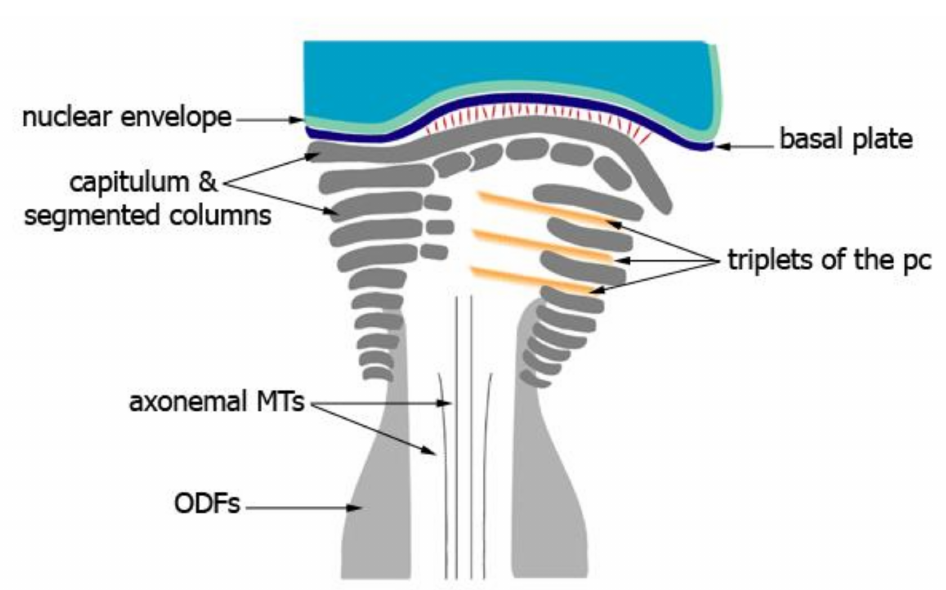
Figure 2. Schematic drawing of the connecting piece of a mature spermatozoon. The singlet MTs approaching the proximal centriole are visible. Striated/segmented columns fuse with the outer dense fibers. The articular structure of the capitulum is depicted. The convex capitulum lines the concave basal plate, a local thickening of the nuclear envelope, and is inserted into the nuclear implantation fossa. Thin fibers linking the capitulum and basal plate are shown in red. A typical distal centriole is no longer present. The proximal centriole disintegrates in rodent spermatozoa. MTs, microtubules; ODFs; outer dense fibers; pc, proximal